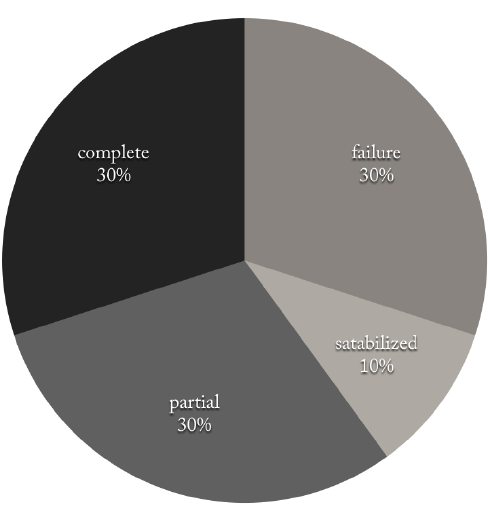
Figure 2 . Itraconazole: outcome of global clinical assessment by treatment (proportion of patients -